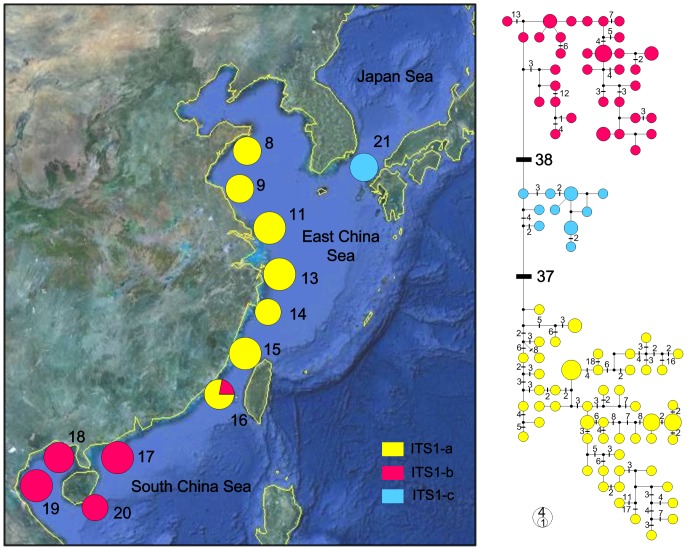
Network and spatial distribution of Cyclina sinensis ITS-1 haplotypes.Three haplogroups showed in the network are colour-coded separately: yellow, ITS1-a; red, ITS1-b; blue, ITS1-c. The sizes of circles are proportional to haplotype frequencies and are separated by one mutation step, unless otherwise indicated by bars with numbers. The small black dots indicate hypothetical missing haplotypes. The spatial distributions of three haplogroups are shown in populations (labelled with numbers as shown in Table 1) by pie diagrams.